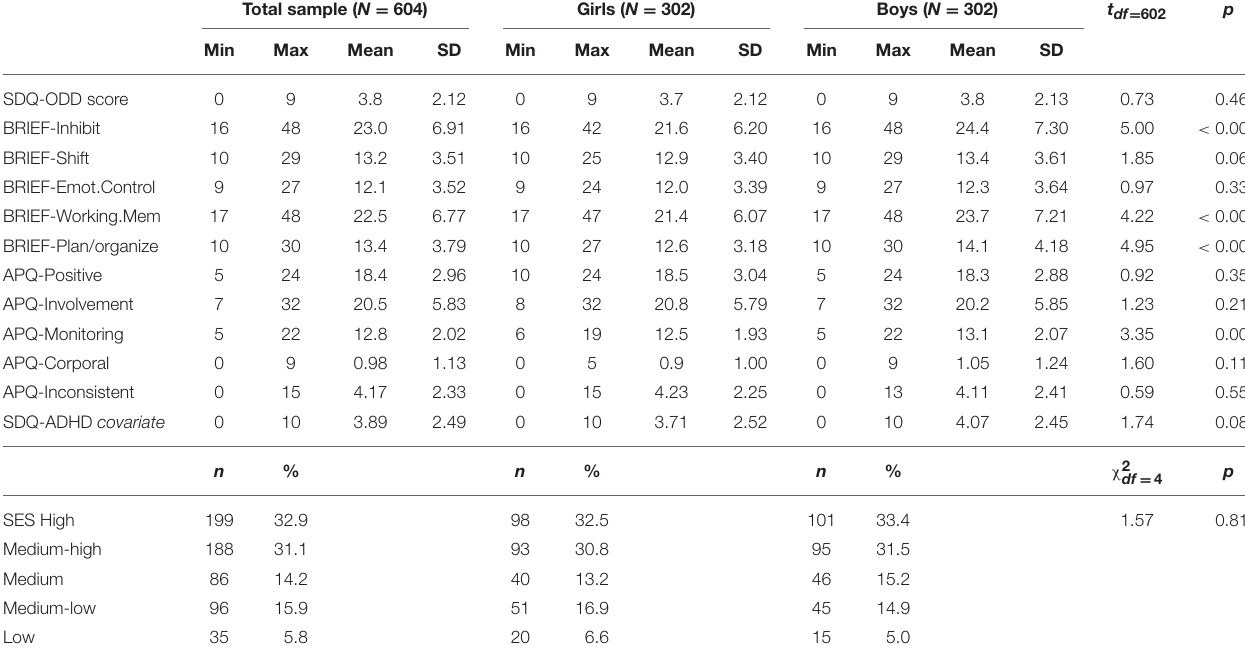
TABLE 1 | Distribution of the variables of the study. Total sample ( N = 604) Girls ( N = 302) Boys ( N =